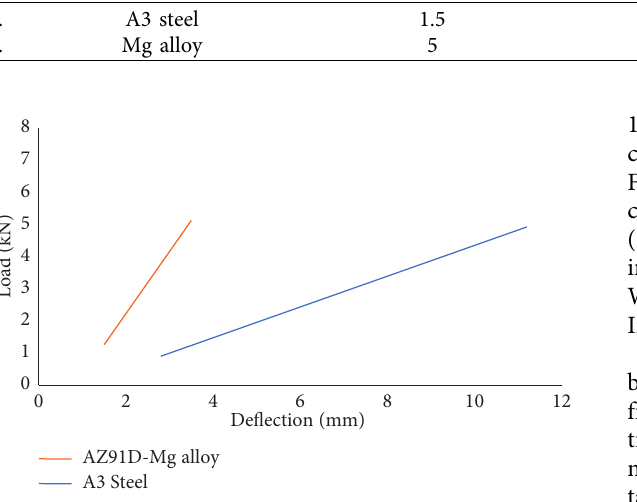
Figure 3: Load vs. deflection curve for both materials of swivel plate.